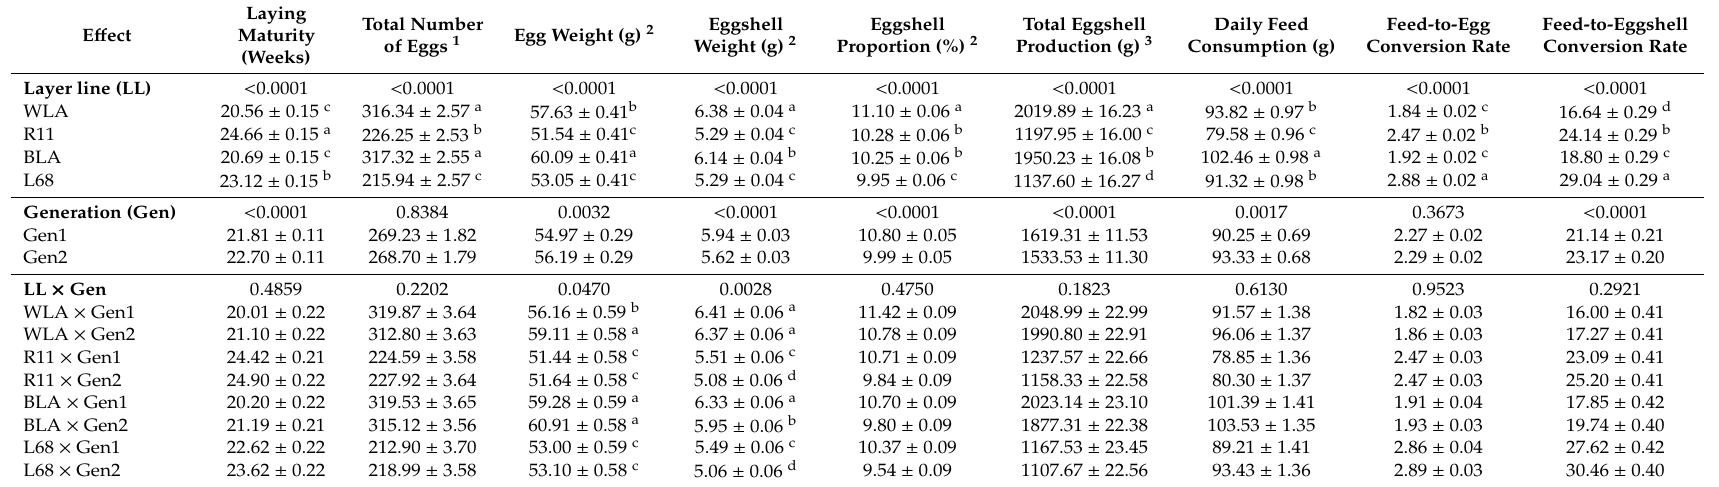
Table 1. Least squares means ± standard errors for production parameters for the e ff ect of layer line (LL), generation (Gen) and their interaction, and the significance levels of the e ff